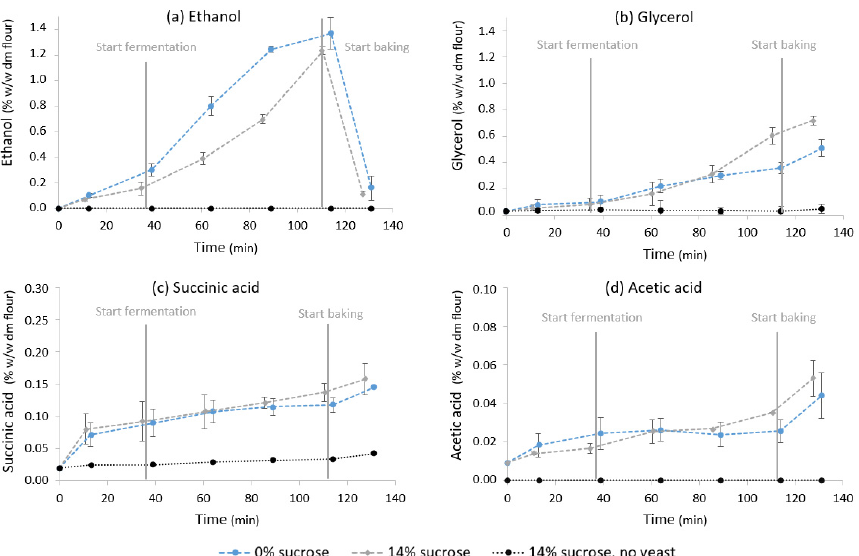
Figure 5. Evolution of ( a ) ethanol, ( b ) glycerol and ( c ) succinic and ( d ) acetic acid concentrations in pastry samples with 8% yeast and 0 and 14% sucrose and samples with 0% yeast and 14% sucrose as a function of time (min) during pastry production. Concentrations are expressed on flour dry matter base (% w / w dm flour). The start of mixing was defined as t = 0. The start of the fermentation and baking phases are displayed. Vertical bars represent standard deviations of duplicate measure- ments.